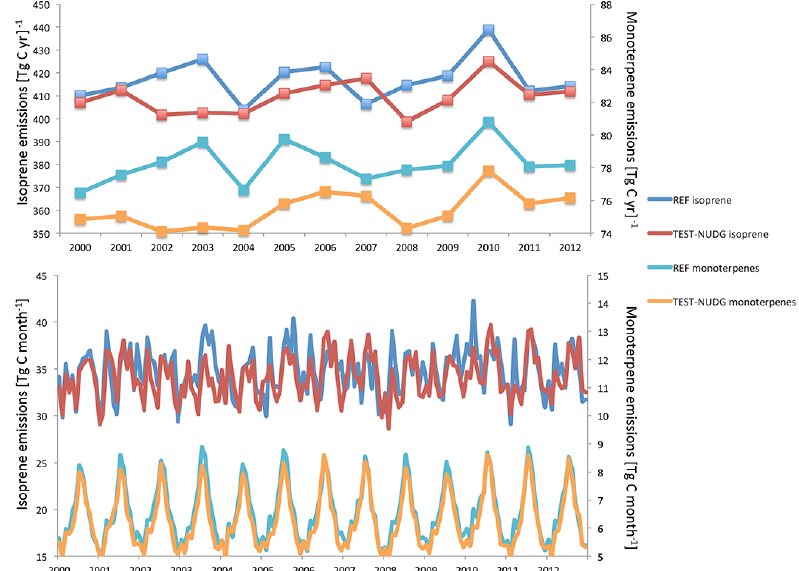
Figure 13. Temporal profiles of isoprene and monoterpenes global annual emissions (TgCyr − 1 ) (upper panel) and global monthly emissions (TgCmonth − 1 ) (bottom panel) for the simulated 2000–2012